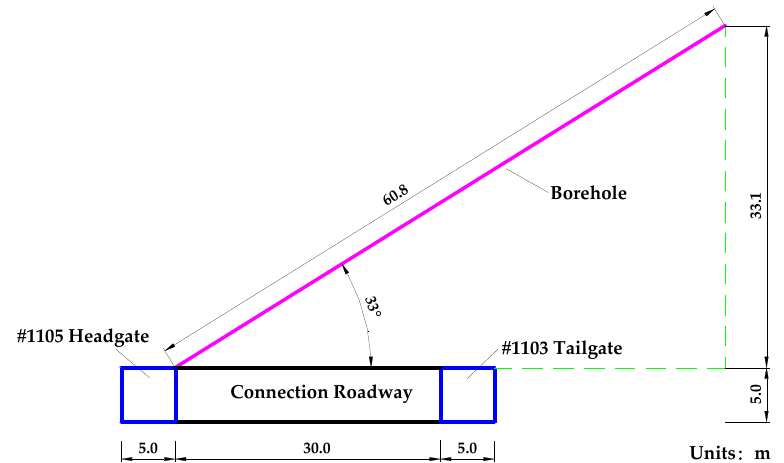
Figure 6. Schematic of borehole layout parameters.